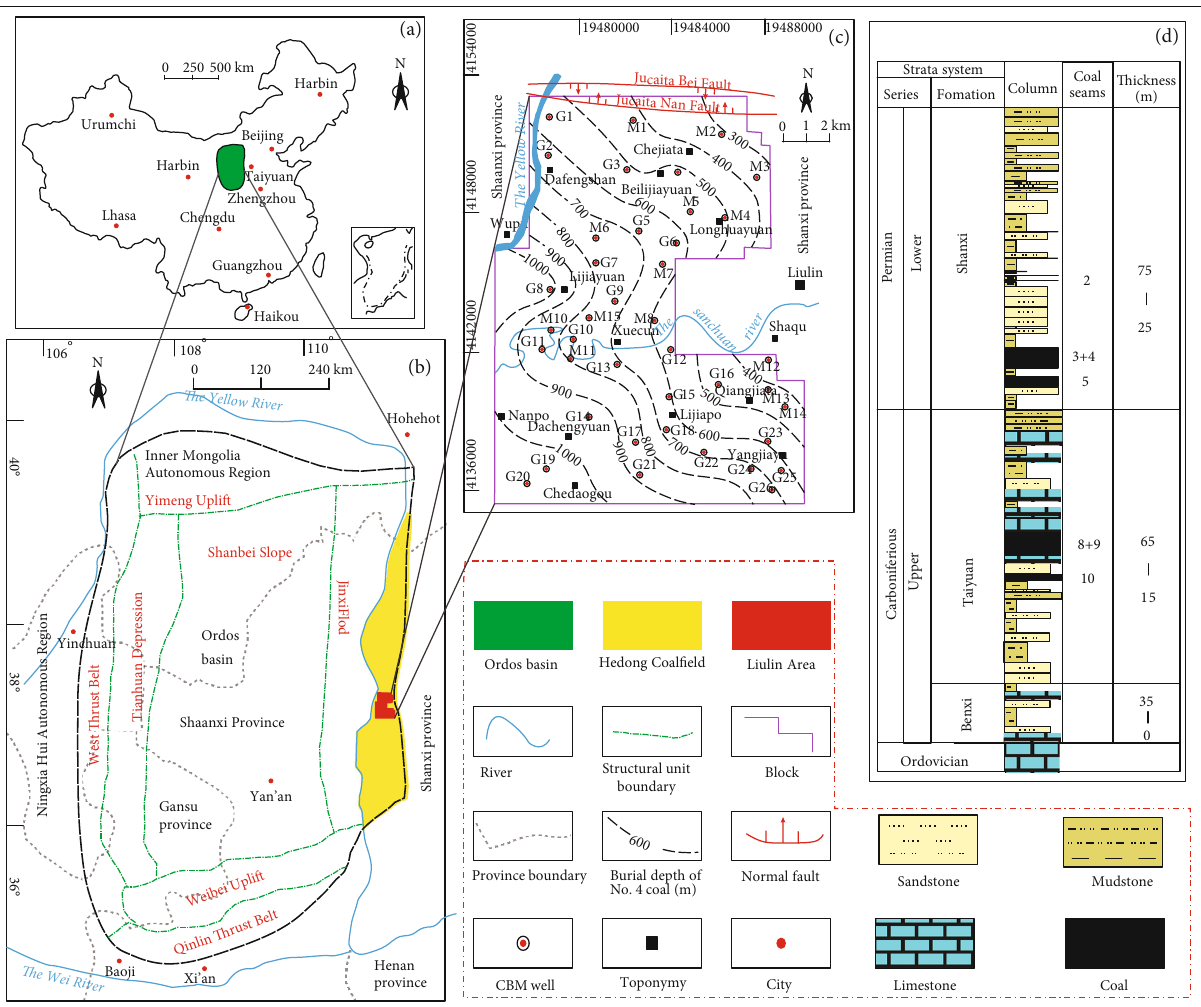
Figure 1: Location of the Liulin area: (a) locations of the Ordos basin in the China map; (b) general location of the eastern margin of the Ordos basin in the tectonic division map; (c) speci fi c locations of the CBM blocks and wells in the eastern margin of the Liulin area; (d) composite stratigraphic column showing coal-bearing formations in the Liulin